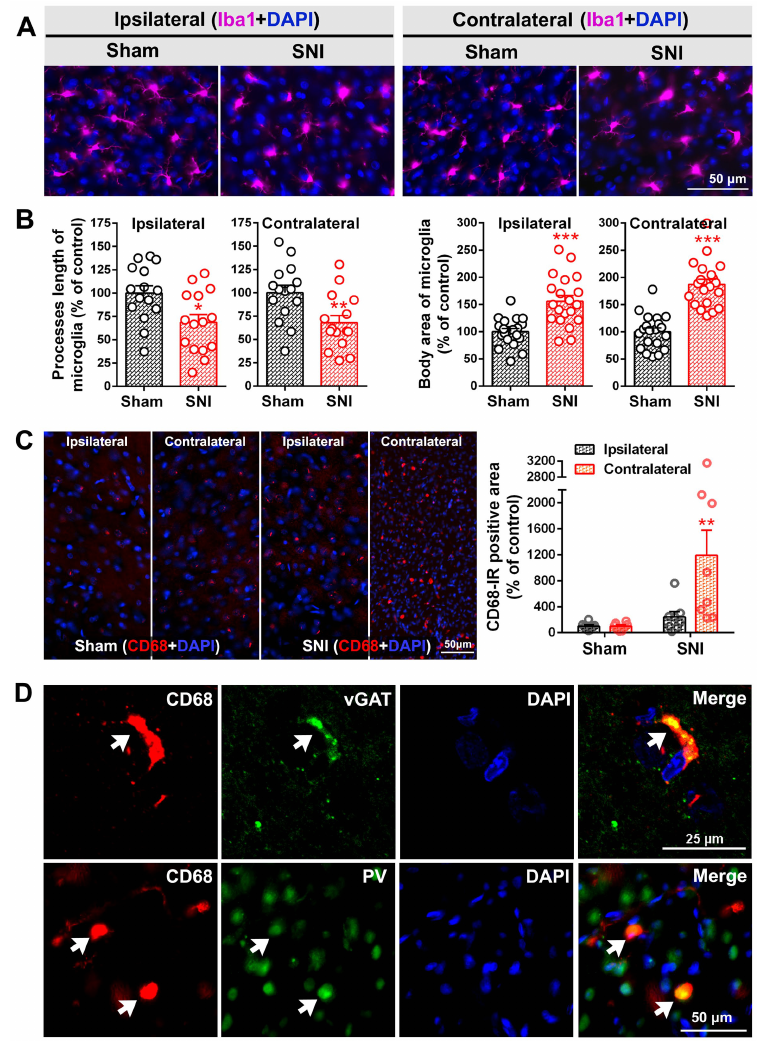
Figure 5. SNI activates the morphological transformation of microglia into amoeba-like cells. ( A ) Representative immunofluorescence staining image of Iba1-IR (microglial marker, magenta) in the bilateral ACC of sham and SNI groups. Scale bar = 50 μm. ( B ) Comparison of the process lengths and cell body areas of microglia in the bilateral ACC of sham and SNI groups. * p- value < 0.05, ** p- value < 0.01, *** p- value < 0.001 versus the sham group (unpaired t test). ( C ) Left: representative immunofluorescence staining image showing CD68-IR in the bilateral ACC in both sham and SNI rats. Scale bar = 50 μm. Right: quantification of the CD68 fluorescence signals in both groups. ** p- value < 0.01 versus the sham group (two-way ANOVA). ( D ) White arrow heads indicate the co-localization of CD68-IR (red) with that of vGAT (green, top) and PV (green, below) 7d post SNI by double staining. Scale bar = 25 µ m in the top line; 50 µ m in the bottom line. Blue fluorescence in (A, C and D) is from DAPI, a nuclear